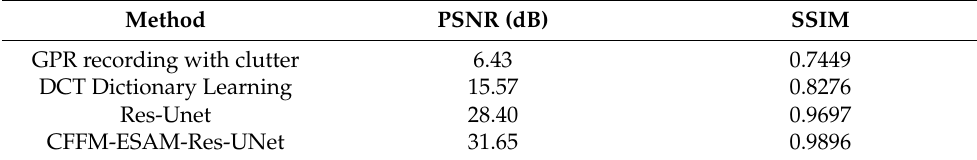
Table 2. Comparison of PSNR and SSIM after diferent methods